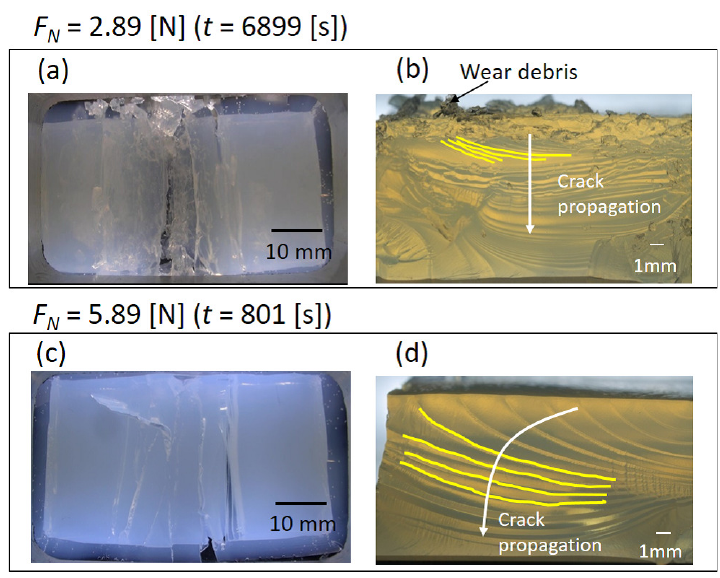
Figure 6. Fatigue crack behavior under two different normal load conditions: ( a , b ) F N = 2.89 N, and ( c , d ) F N = 5.89 N. Images from bottoms views ( a , c ) are taken just before entire rupture of each